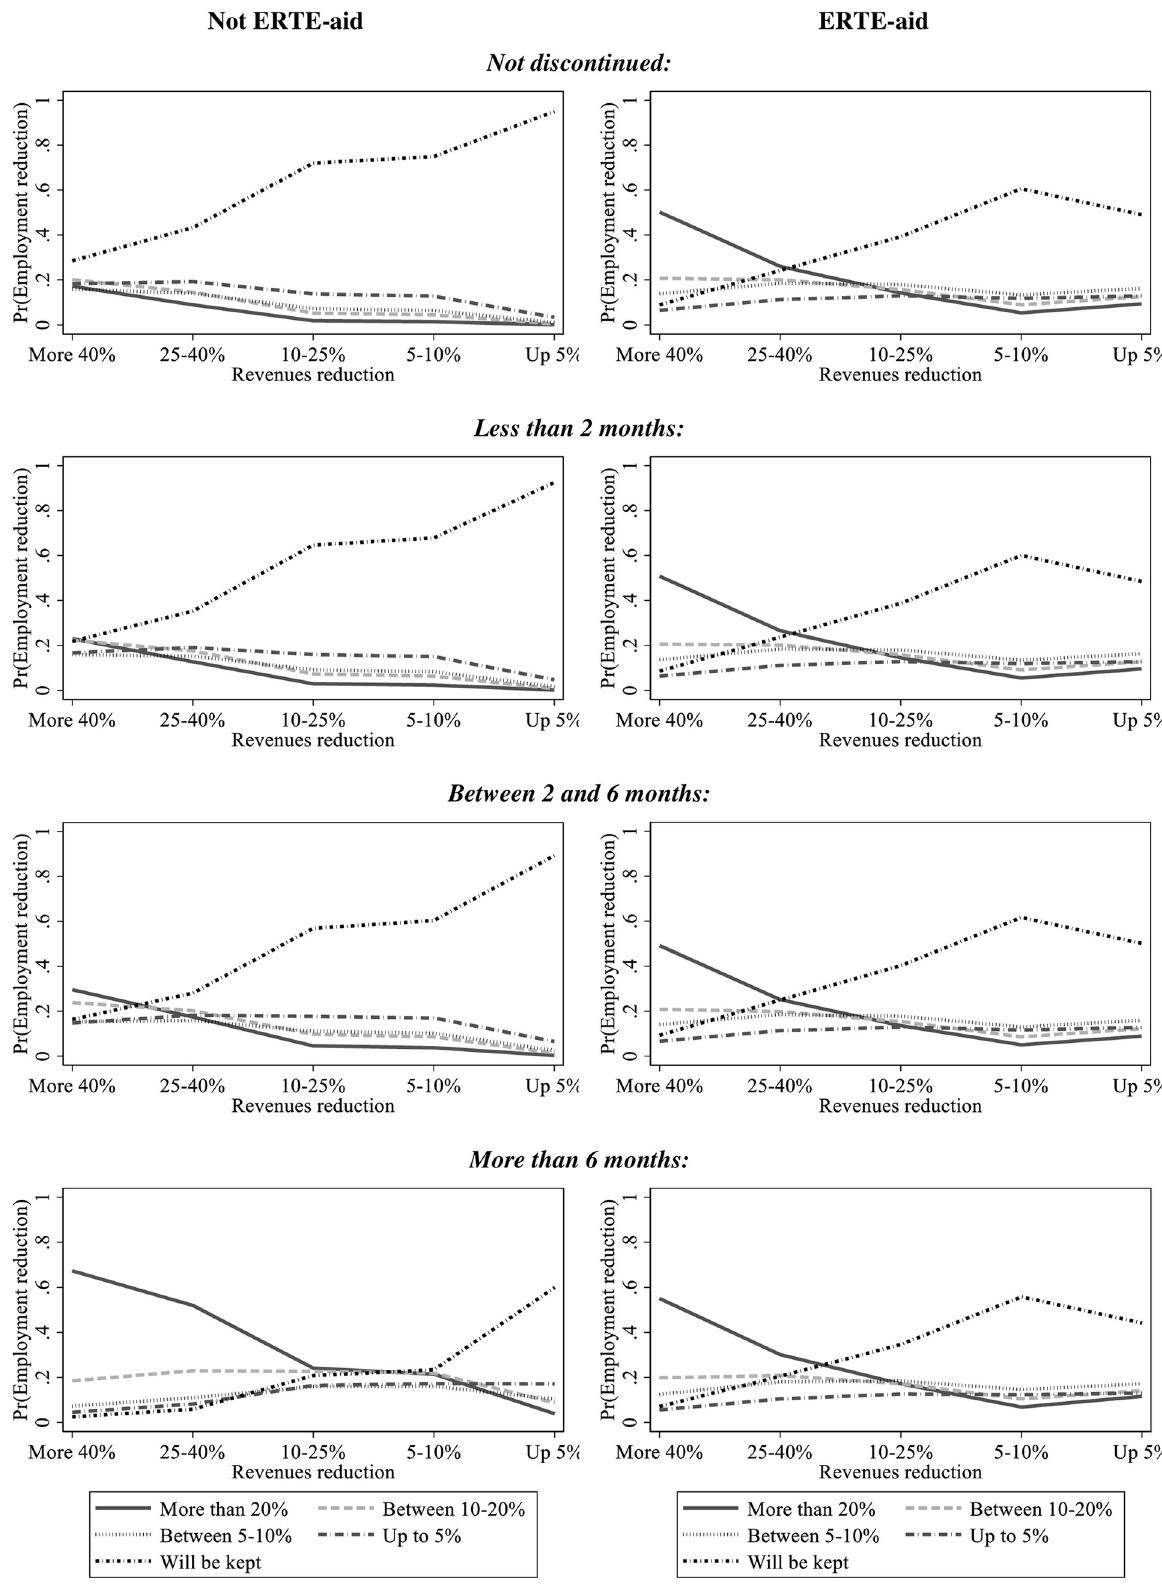
Fig 2. Predicted probability of layoffs from revenue reduction and activity prospects for firms with or without ERTE-aid. https://doi.org/10.1371/journal.pone.0253331.g002 PLOS ONE | https://doi.org/10.1371/journal.pone.0253331 June 23,